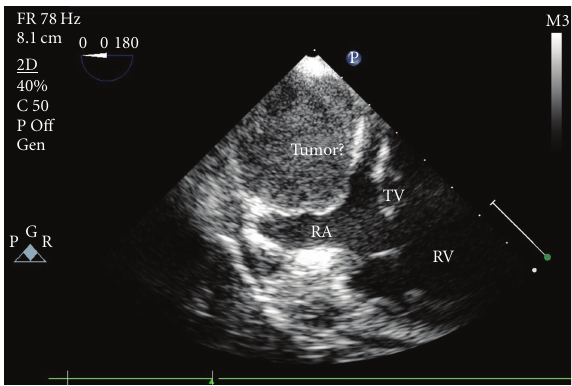
Figure 2: Transesophageal echocardiogram showing the homoge- nous echogenic mass (tumor) attached to the posterior wall of the right atrium (RA) above the tricuspid valve (TV), RV: right ventricle.